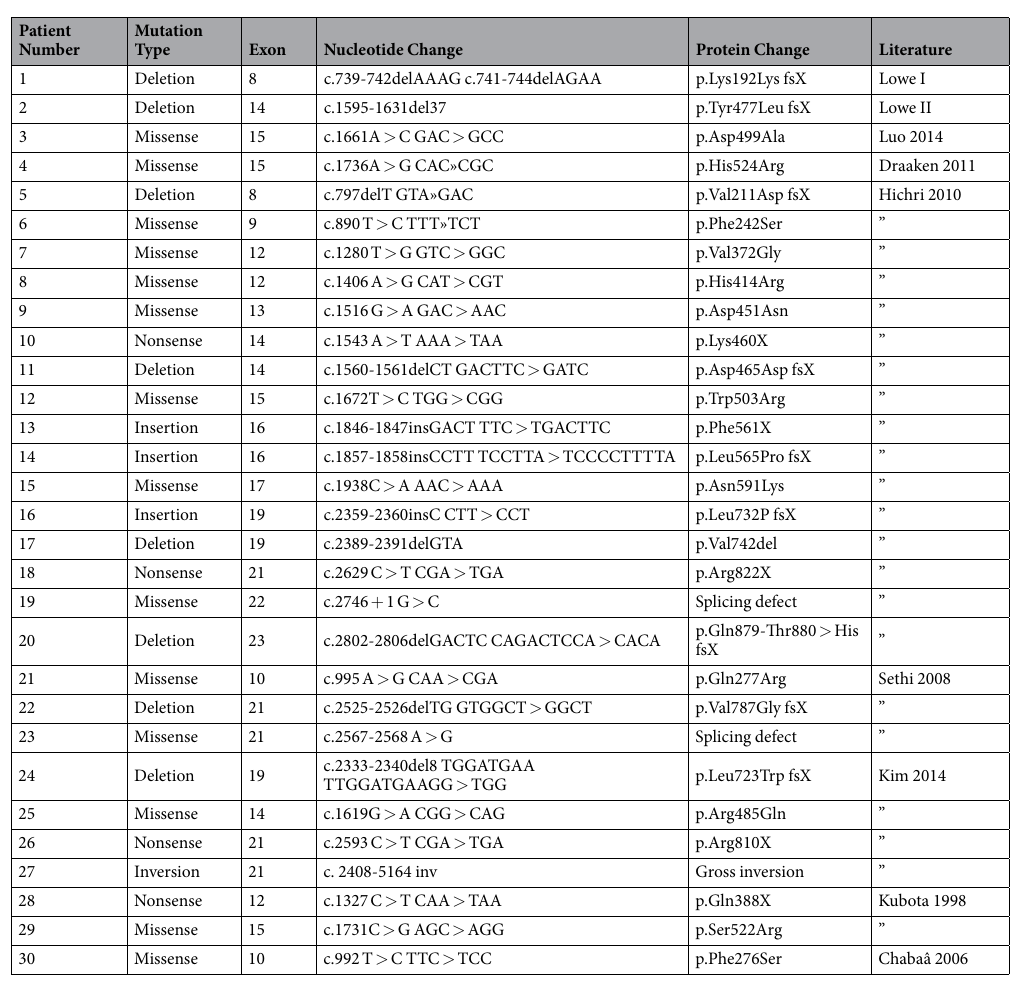
domain, which results in unstable transcribed protein and the loss of OCRL activity as demonstrated by PI(4,5) P2 activity. Patient 2’s deletion occurs within exon 14, directly affecting the 5-phosphatase domain, which would lead to incomplete transcription of the ASPM-SPD-2-Hydin (ASH) domain, and the C-terminal, catalytically inactive RhoGAP-like domain. Lowe 1 had a four base pair deletion mutation in the region between the PH and 5-phosphatase domains, causing the OCRL protein to shorten from 901 amino acids to 200 amino acids and lose its inositol 5-phosphatase domain. This frameshift mutation also caused Lowe 1 to have significantly reduced levels of OCRL in his keratinocytes as compared to controls. The deletion mutation in Lowe 2 occurred in the 5-phosphatase domain and caused a frameshift that shortened the OCRL protein to 506 amino acids. Both patients presented with bilateral congenital cataracts and elevated intraocular pressure that required a number of glaucoma surgeries. It is recognized that the majority of OCRL1 mutations that cause Lowe syndrome are deletion and early trun- cation mutations, and a smaller number of mutations are missense mutations that may shed more light on the functional importance of each of the domains 36 . Most of the currently reported mutations for Lowe syndrome (eye, brain, and kidney) are located within the 5-phosphatase domain and the RhoGAP-like domain, whereas the mutations associated with Dent’s disease (kidney alone) are more in the N-terminal domain preceding the catalytic and C-terminal lipid binding domains 36 . Based on our analysis of the glaucoma associated mutations, the majority of missense mutations occur within the 5-phosphatase domain, and only 30% are found within the RhoGAP-like domain, suggesting that the enzymatic functions of 5-phosphatase are important in causing the glaucoma phenotype. However, on further structural analysis based on the location of mutated amino acids, only 4 out of 16 missense mutations were in the active site or near the core of the catalytic domain of 5-phosphatase. Further, the symptoms of the patients were not more severe than that of mutations occurring outside of the 5-phosphatase domain. This raises an important question that has been noted by several groups, namely, how important is the 5-phosphatase function in the cause of Lowe syndrome, if PI(4,5)P2 levels are high also in the Dent’s disease patient derived